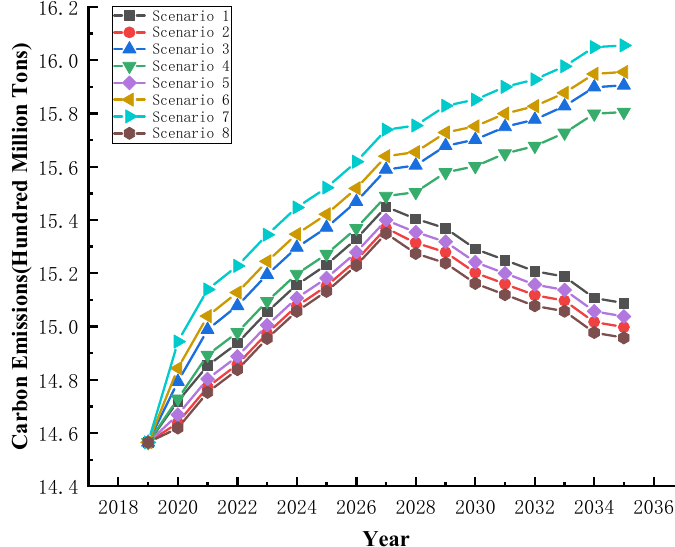
Figure 6. Carbon dioxide emission trends in the Yellow River Basin under different scenarios.